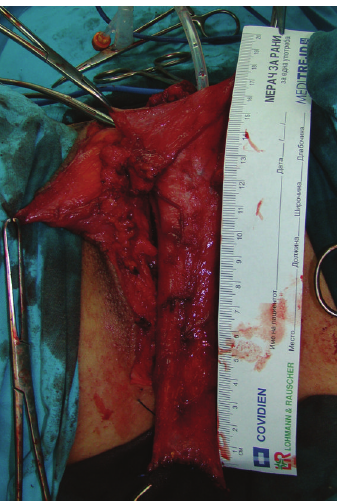
Figure 5: Long tube consisting of vascularized penile skin and urethral flap is inverted to form neovagina.